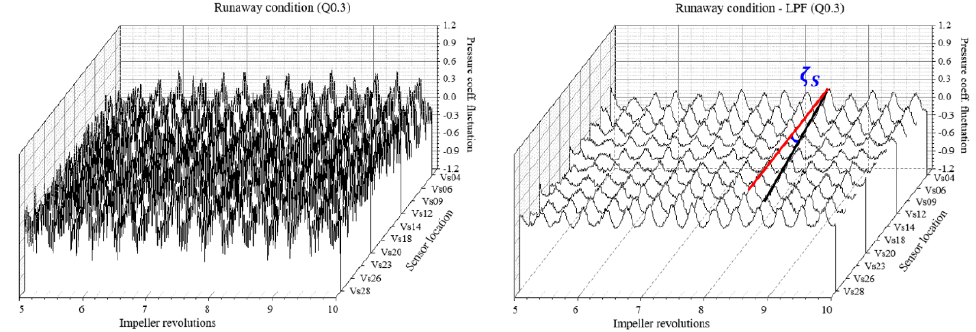
Figure 13. Time histories of low-pass-filtered signals at all monitoring points in the vaneless space under the runaway condition.